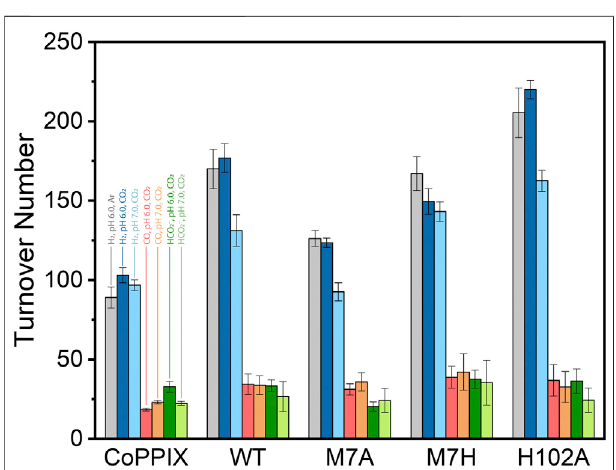
FIGURE3| TurnovernumbervaluesobtainedforCoPPIXandcobaltcyt b 562 mutants under irradiation with light for 8 h in 100 mM ascorbic acid, 1 mM [Ru(bpy) 3 ] 2+ , and 200 mM potassium phosphate. The bars represent theTONofeachcatalystatpH6.0inabsence(H 2 :gray)andpresenceof CO 2 (H 2 : dark blue, CO: red, HCO 2 − : dark green); and in the presence of CO 2 atpH7(H 2 :lightblue,CO:orange,HCO 2 − :lightgreen).Theexperimentswere runontriplicateanderrorbars